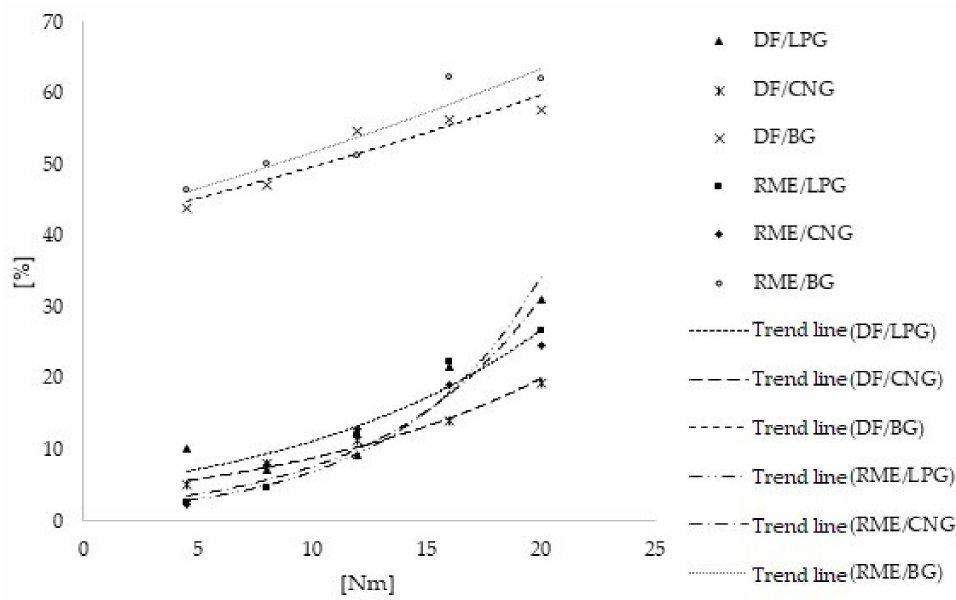
Figure 2. The share of liquid fuel in the fuel dose depending on the engine